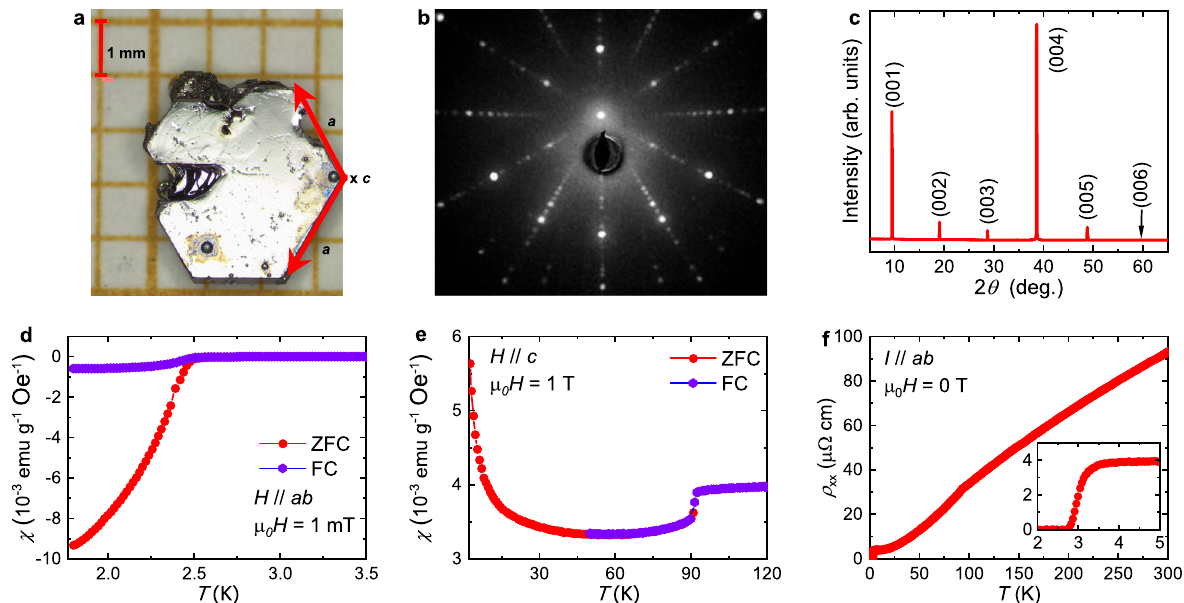
Fig. 1 (Color online) Characterization of CsV 3 Sb 5 single crystals. a Optical microscope photograph of a single crystal with the crystallographic axes highlighted by arrows. Notice the obvious hexagonal symmetry. b Laue x-ray diffraction image of the single crystal along the 001 direction. c X-ray diffraction pattern obtained from a single crystal sample. d Temperature dependence of magnetic susceptibility in an applied fi eld of 1 mT along the ab plane highlighting the superconducting transition. e Temperature dependence of magnetic susceptibility in an applied fi eld of 1 T along the c axis emphasizing the CDW transition at 95 K. f Electrical resistivity as a function of temperature under zero applied fi